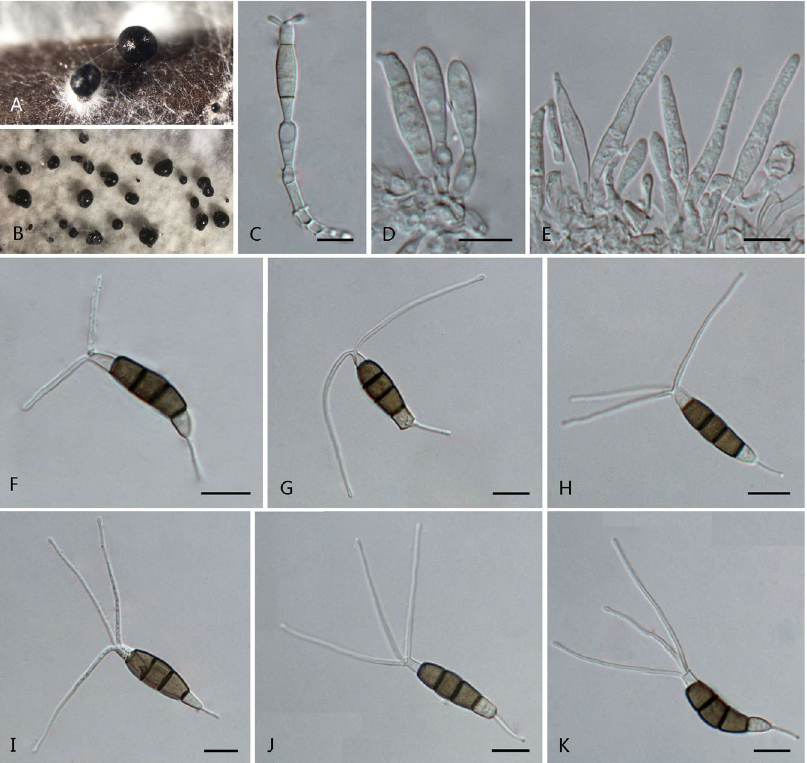
Figure 16. Pseudopestalotiopsis chinensis (from ex-holotype culture CGMCC 3.18152 ( = LC3011)). ( A ) Conidiomata sporulating on pine needle. ( B ) Conidiomata sporulating on PDA. ( C–E ) Conidiogenous cells and conidia. ( F–K ) Conidia. Scale bars = 10 μ